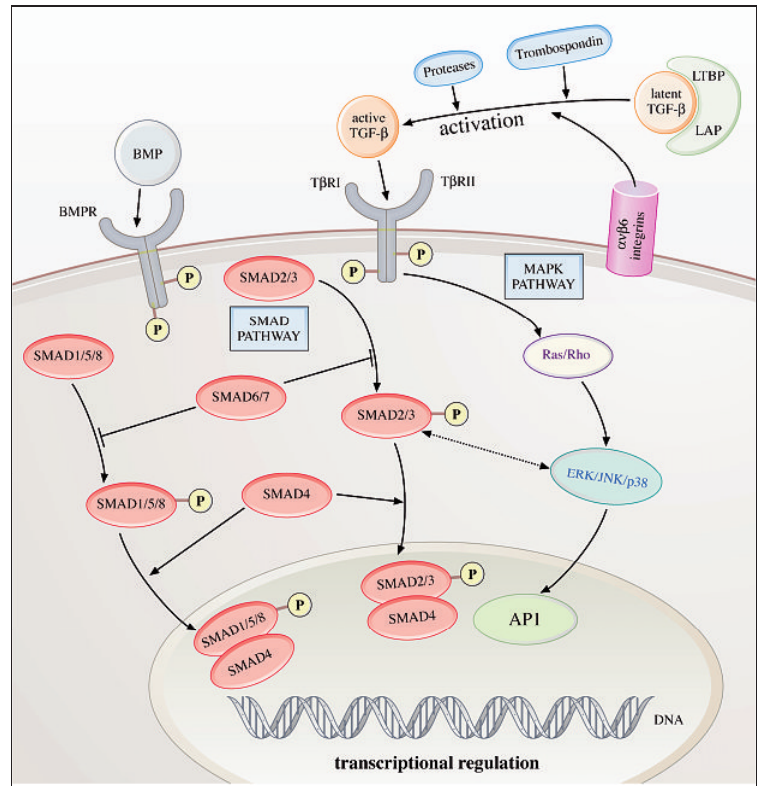
TheTGF- ββ signalling pathway. TGF- β isoforms are secreted in a complex with the latency associated peptide (LAP) and the latentTGF- β binding proteins (LTBP).TGF- β activation is controlled by proteases e.g, thrombospondin 1 or integrins. ActiveTGF- β ligands bind toTGF- β receptors, initiating the recruitment and phosphorylation of SMAD2/3.The bone morphogenic protein (BMP) family of theTGF- β superfamily bind to BMP receptors (BMPR), thereby activating SMAD 1/5/8. SMAD-independent path- ways, such as mitogen-activated protein kinase (MAPK) pathway may interact with classicalTGF- β signalling. An example is shown, whereby the MAPK pathway activates AP-1, which modulates (SMAD-induced) transcriptional activity (see text for further